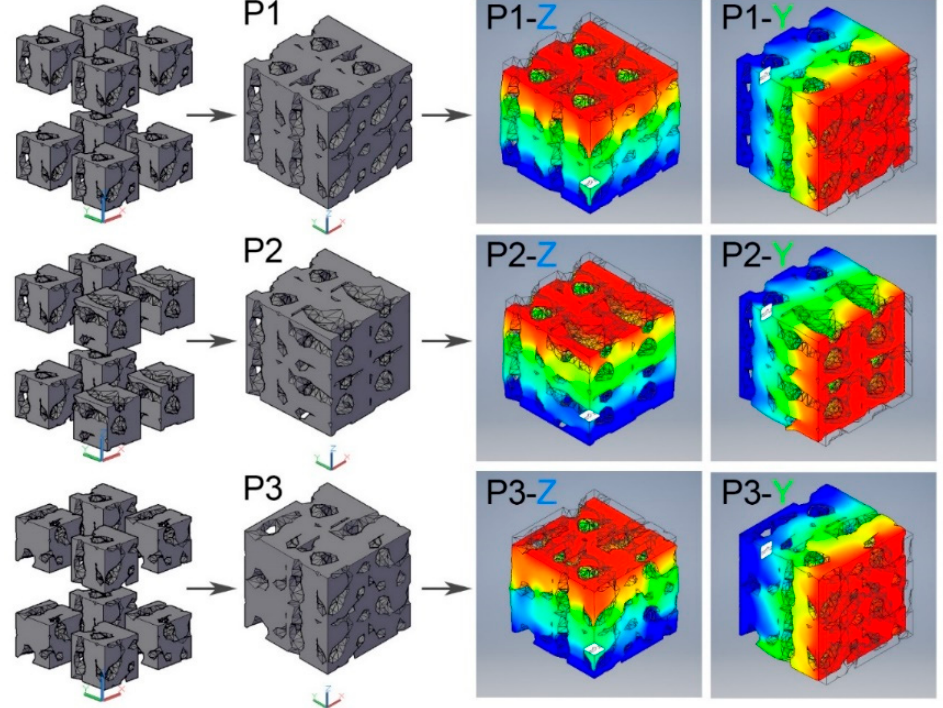
Figure 5. Composites designed through the permutation of elementary models and compression simulations on composites (using the simulation method descripted in Section 3.3.).